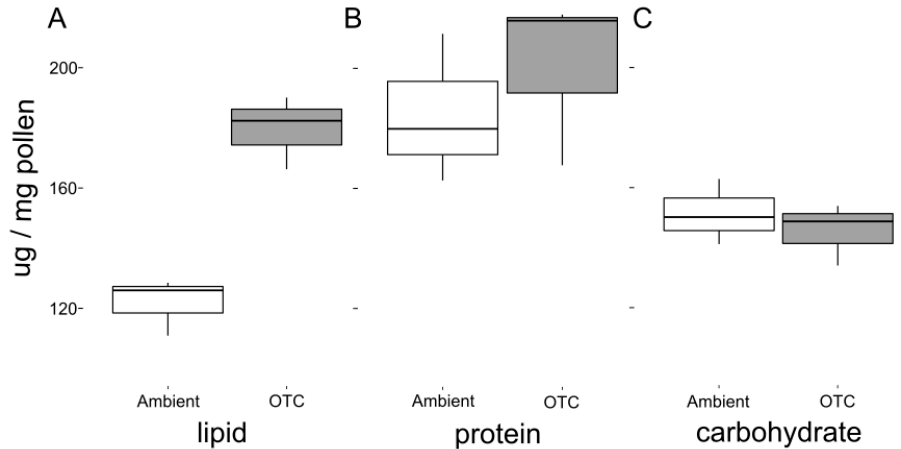
Figure 1. Boxplots comparing the concentration (ug / mg pollen) of ( A ) lipid, ( B ) protein, and ( C ) carbohydrate from subsamples of pooled collections from ambient and warmed (OTC) plots.